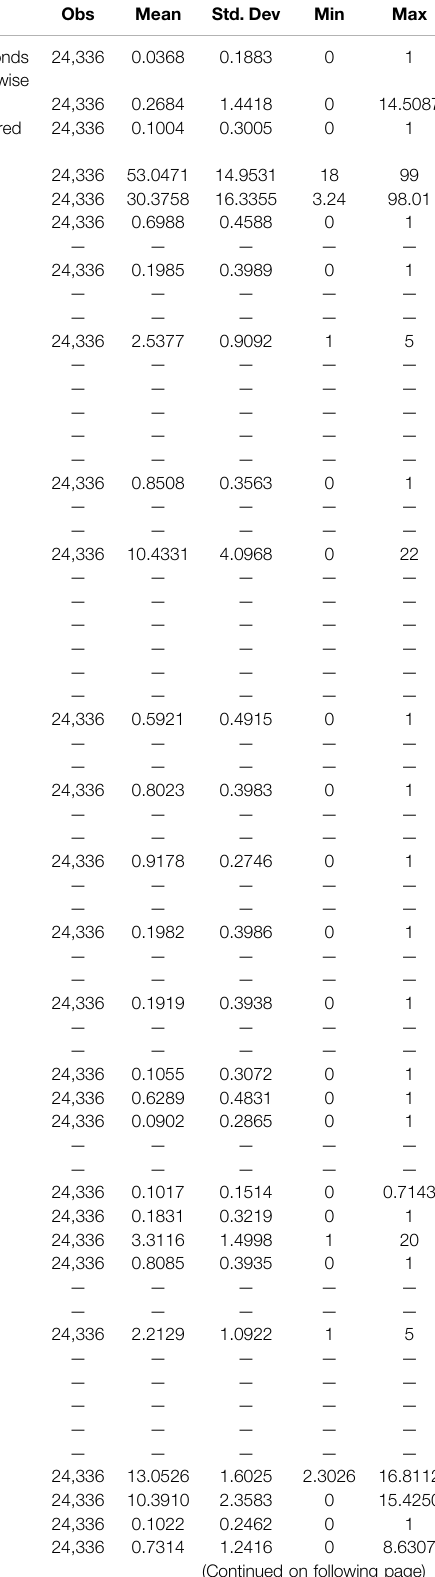
TABLE 1 | Descriptive statistics of the variables.